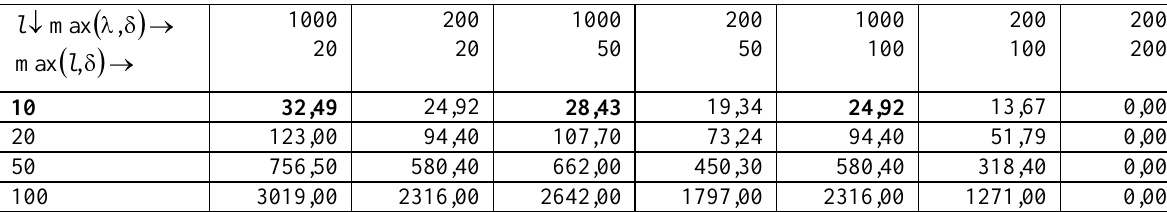
Table 4. Out-of-area gravimetric geoid standard deviation, Estonian gravimetric survey parameters: Units: